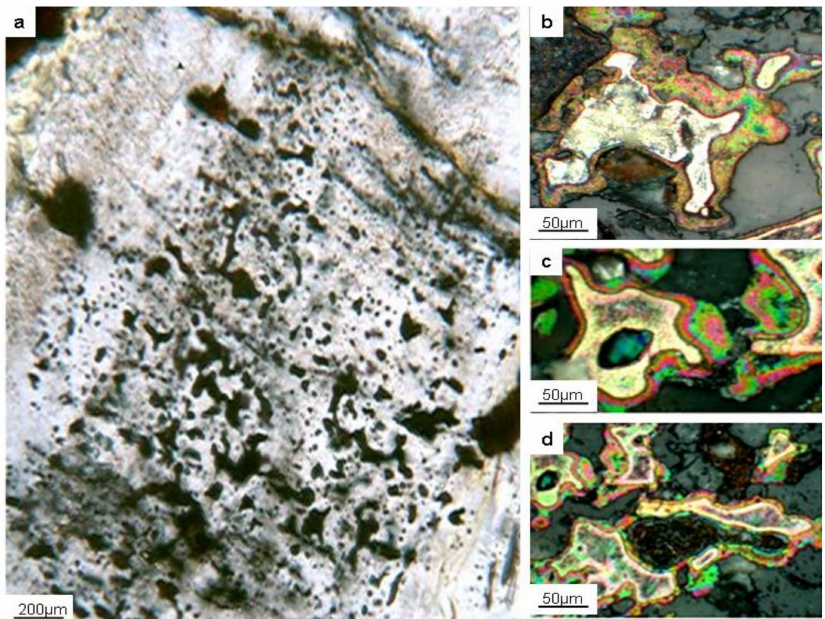
Figure 13. Filling of vacuoles with native gold in quartz at the Olcha deposit (( a ) quartz in transmitted light without analyzer, black—vacuoles; ( b – d ) in reflected light, native gold in quartz, structural